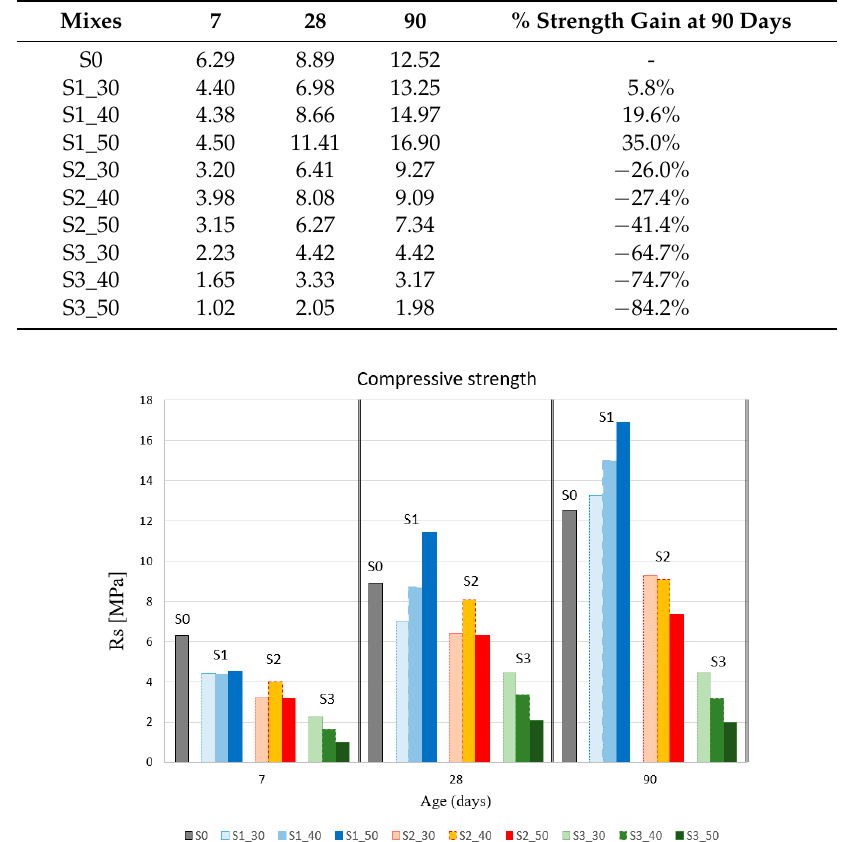
Table 4. Compressive strength results.